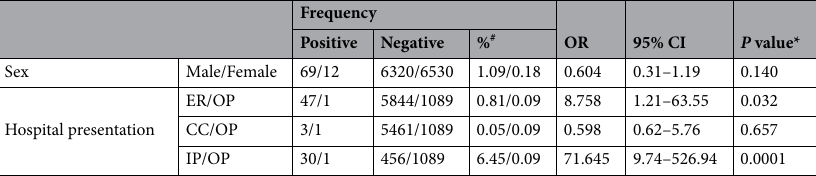
Table 4. Sex and hospital presentation of febrile patients associated with malaria infection. ENTER method of logistic regression model was used. Data presented as n, ( # ) % of malaria positive within the same group, (*) P- value < 0.05 is